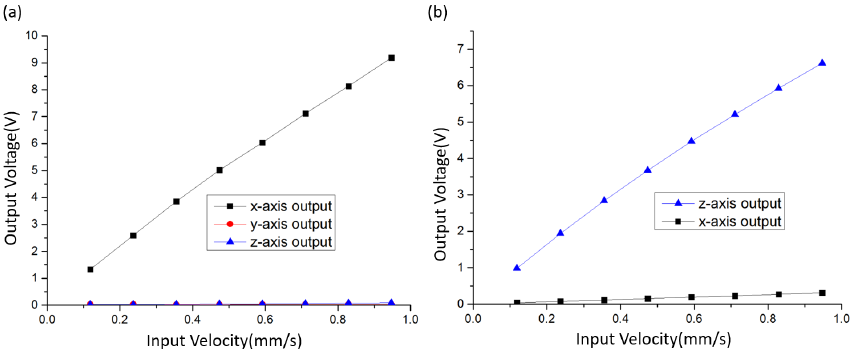
Figure 7. The output voltage of x-axis, y-axis, and z-axis devices when the vibration of different amplitude was applied along x, y ( a ), and z directions ( b ), respectively.